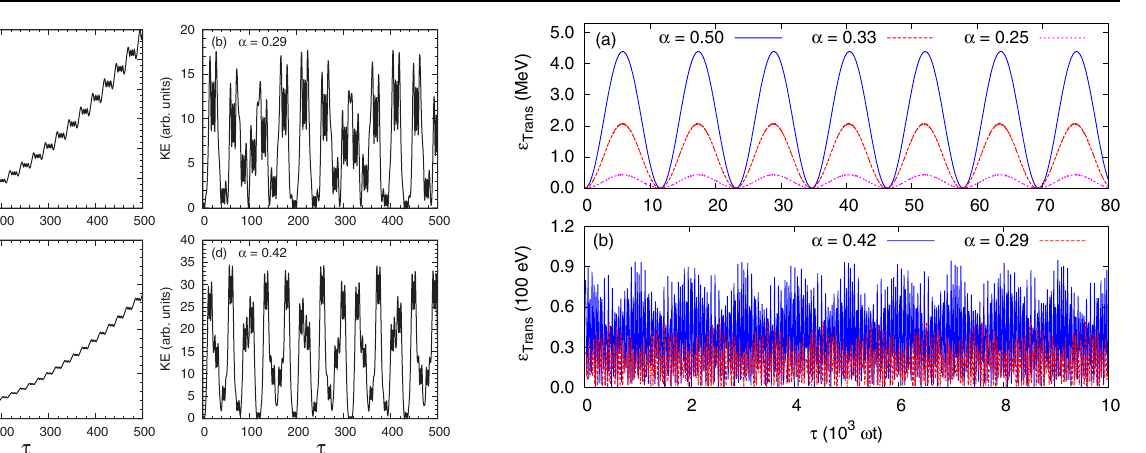
FIG. 2. Temporal evolution of the kinetic energy with different values of (cid:3) : (a) 0.25, (b) 0.29, (c) 0.33, and (d) 0.42 is outcome for v x ð (cid:4) Þ , but the corresponding integral for v y ð (cid:4) Þ